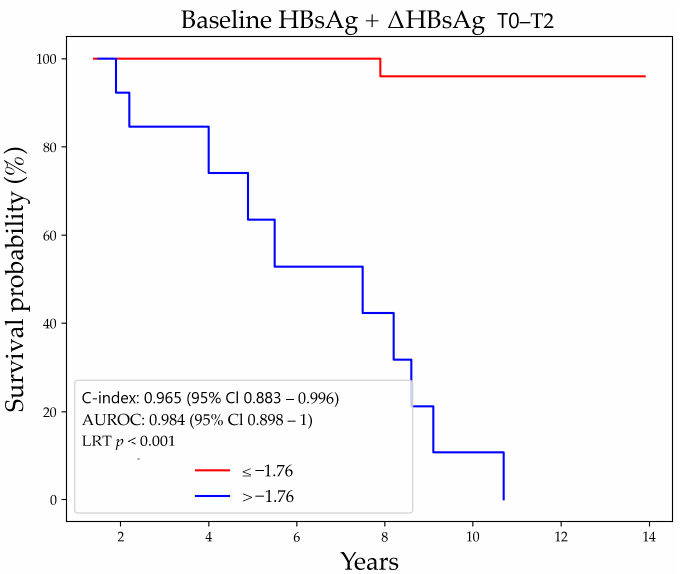
Figure 4. Predictiveness of the model combining baseline HBsAg ≤ 2.00 Log IU/mL and ∆ HBsAg T0–T2 > 0.30 Log IU/mL for HBsAg loss. Abbreviations–HBsAg decline ( ∆ HBsAg), hepatitis B surface antigen (HBsAg), timepoint (T).